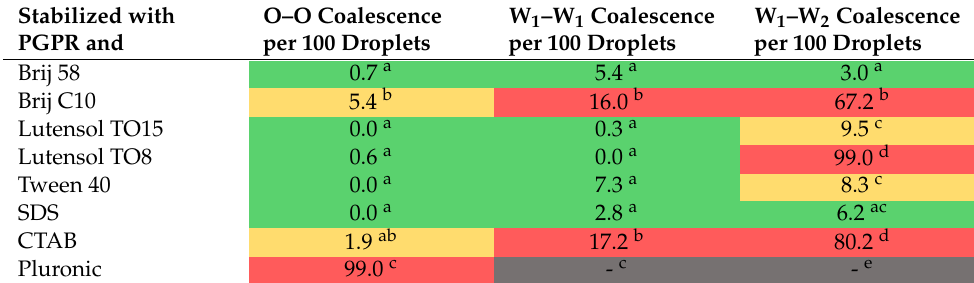
Table 2. Evaluation of the stability against each possible coalescence paths for the combination of PGPR (1 wt%) with different hydrophilic surfactants (1 wt%). The values and groups of significant difference ( p > 0.05) are given for the double emulsion droplets after one day of storage. The color scheme is given to guide the eye for good (green), intermediate (yellow) and poor (red) stability against coalescence, as observed in the experiments. Grey values could not be measured due to complete phase